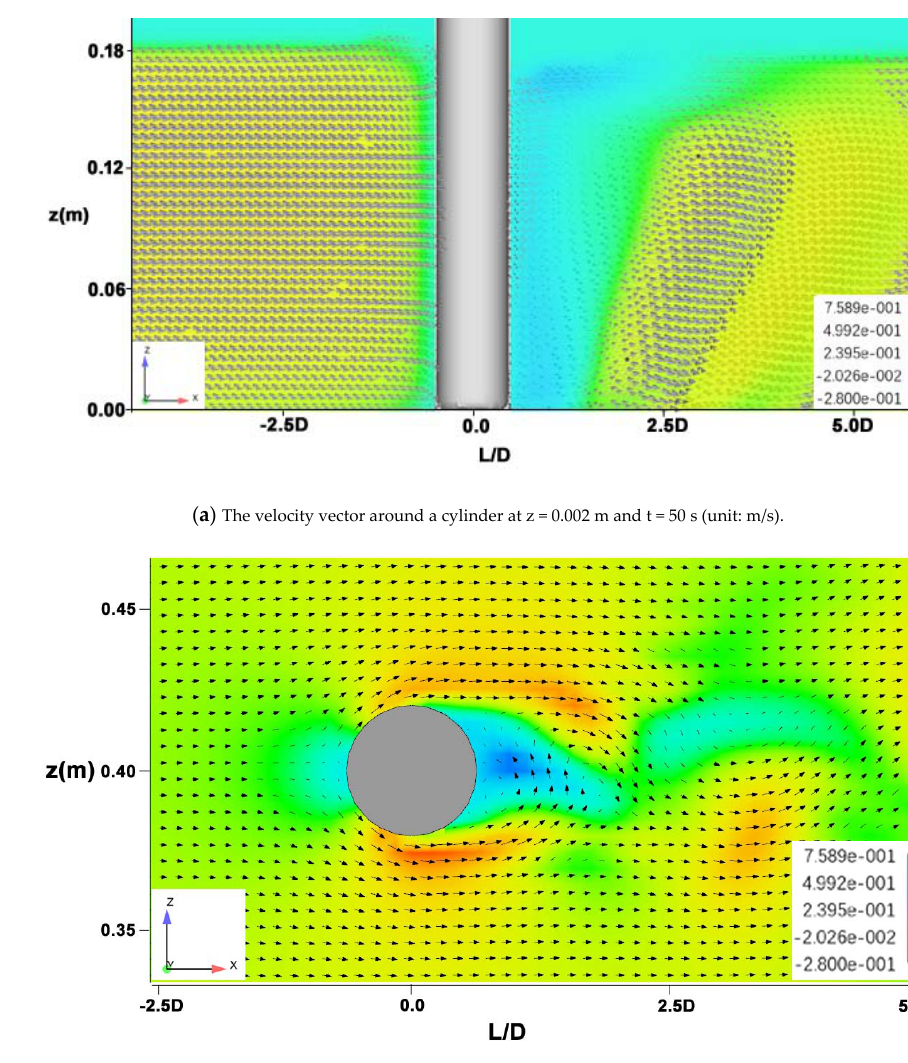
Figure 8. of excess shear stress on the riverbed (z = 0.002 m, t = 50 s) (unit: Pa). 212 Figure 8. Of excess shear stress on the riverbed (z